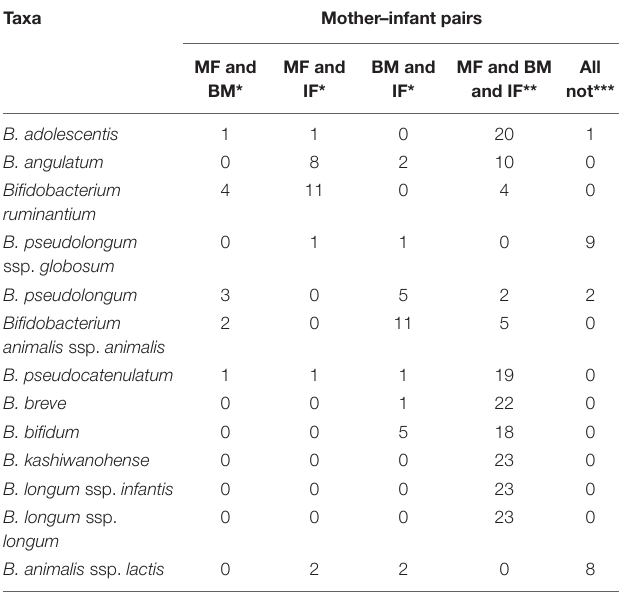
TABLE 3 | The occurrence frequency of 13 Bifidobacterium species or subspecies in samples from 23 mother–infant pairs.